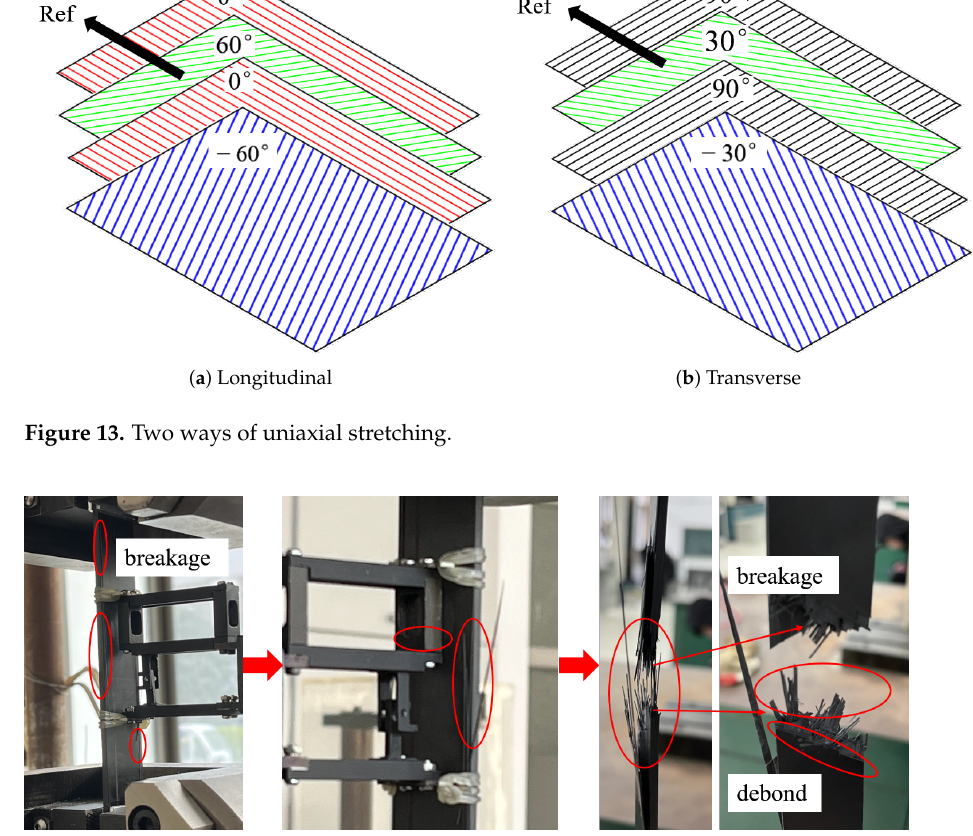
Figure 14. Longitudinal fracture